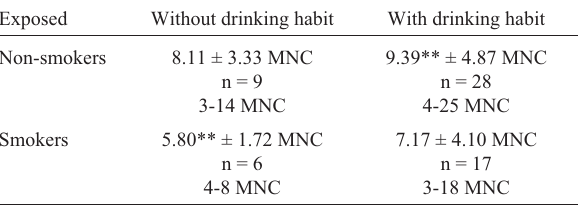
Table VI - Average numbers of micronucleated cells (in 3000 cells analyzedperindividual)ofthegroupofindividualsexposedtobyproducts of petrol and lead, with regard to smoking and drinking